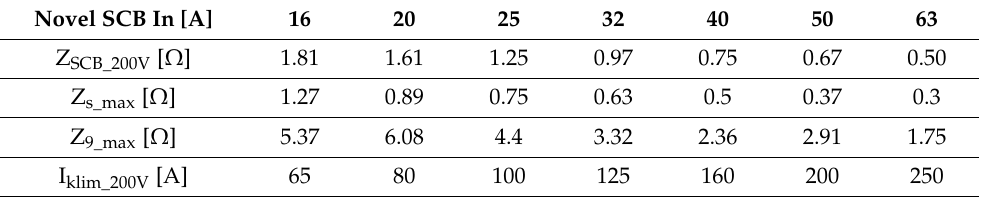
Table 5. Conventional SCB and circuit parameters according to the coordination table (Table